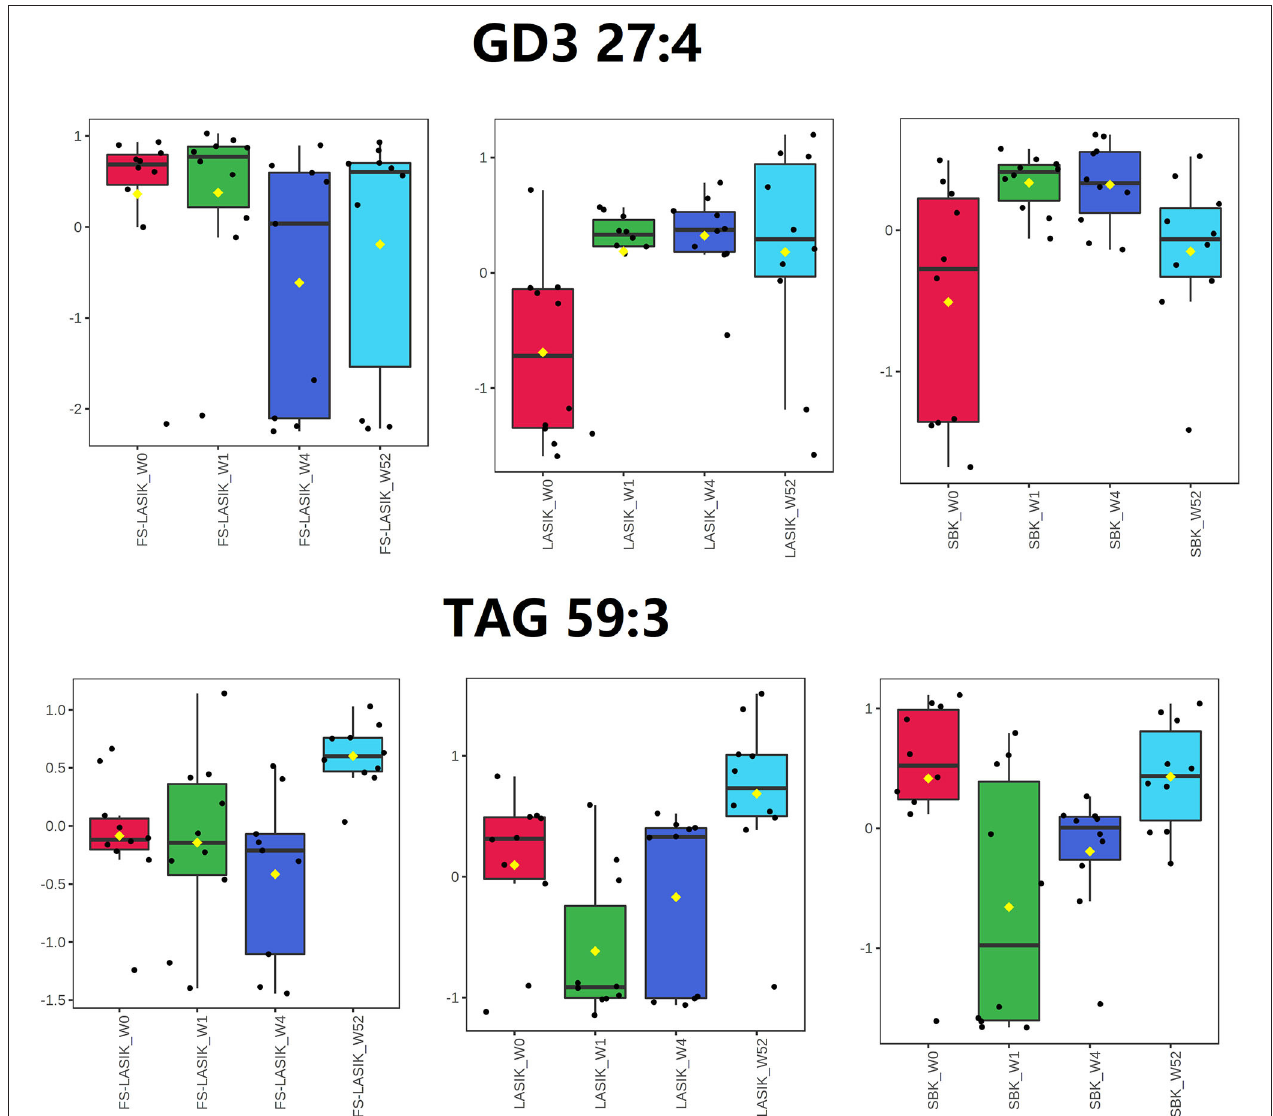
FIGURE 3 | Box and whisker plots showing the intensity changes over time for GD3 27:4 and triacylglycerol (TAG)